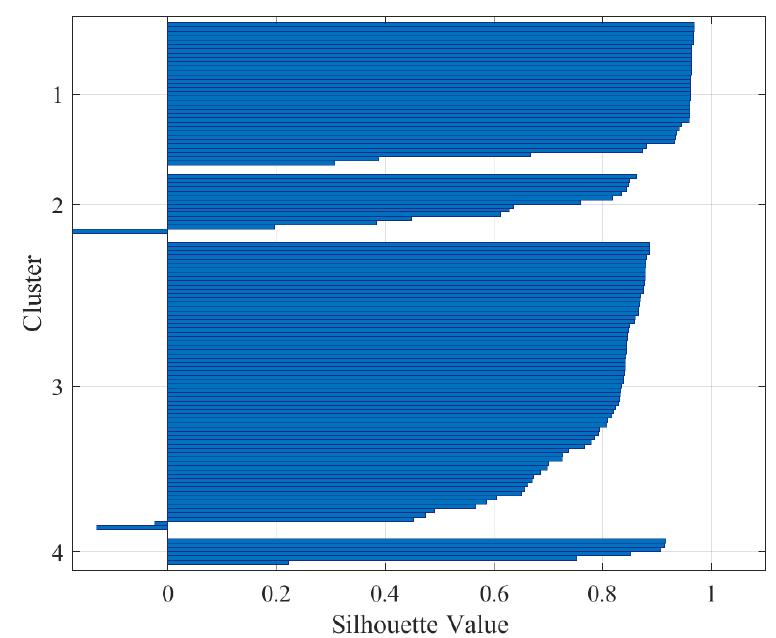
Figure 8. Silhouette plot of clustered rotor harmonics data with k =